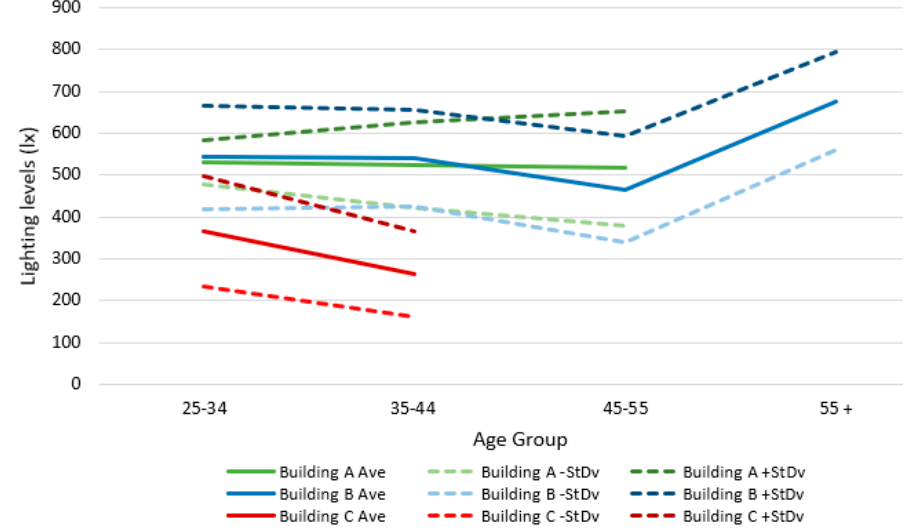
Figure 20. Illuminance measurements on the users’ desks in regards their age, in which, the occupants’ response for liking their visual environment was positive. response for liking their visual environment was